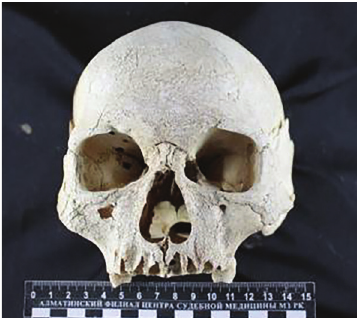
Figure 2 - Skull, left view (the arrow indicates the deformity in the occipital bone)